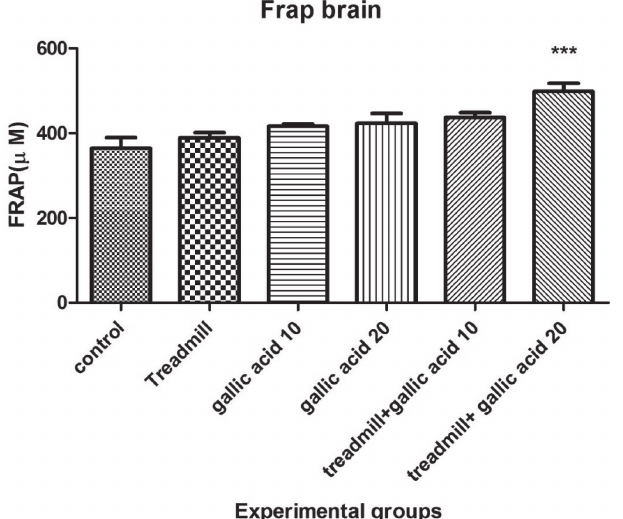
FIGURE 3 - The effects of gallic acid and physical exercise, alone and combined, on brain antioxidant capacity; *** = ( p <0.001).